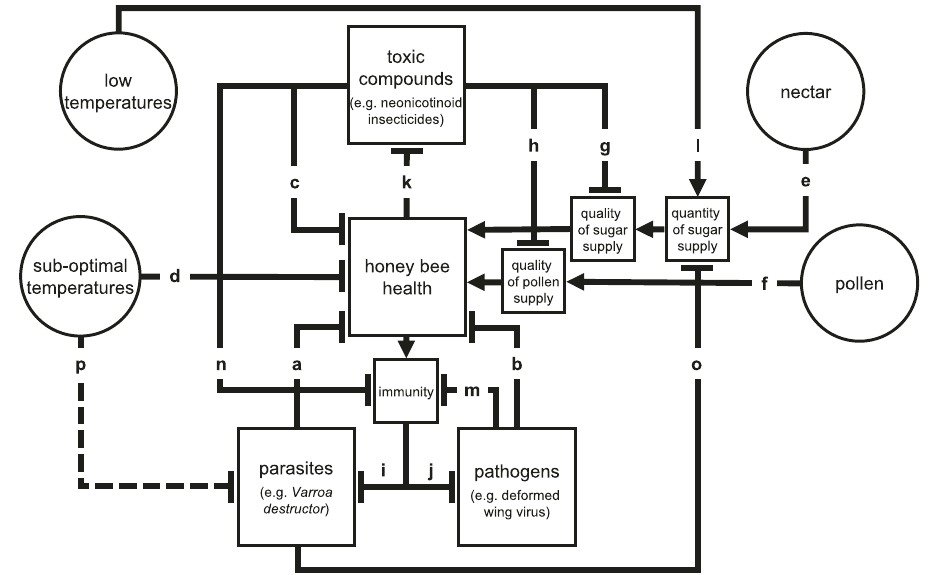
Fig. 1 | The health of honey bees as in fl uenced by multiple factors and their effects. In the conceptual model of bee health bar-headed lines denote negative